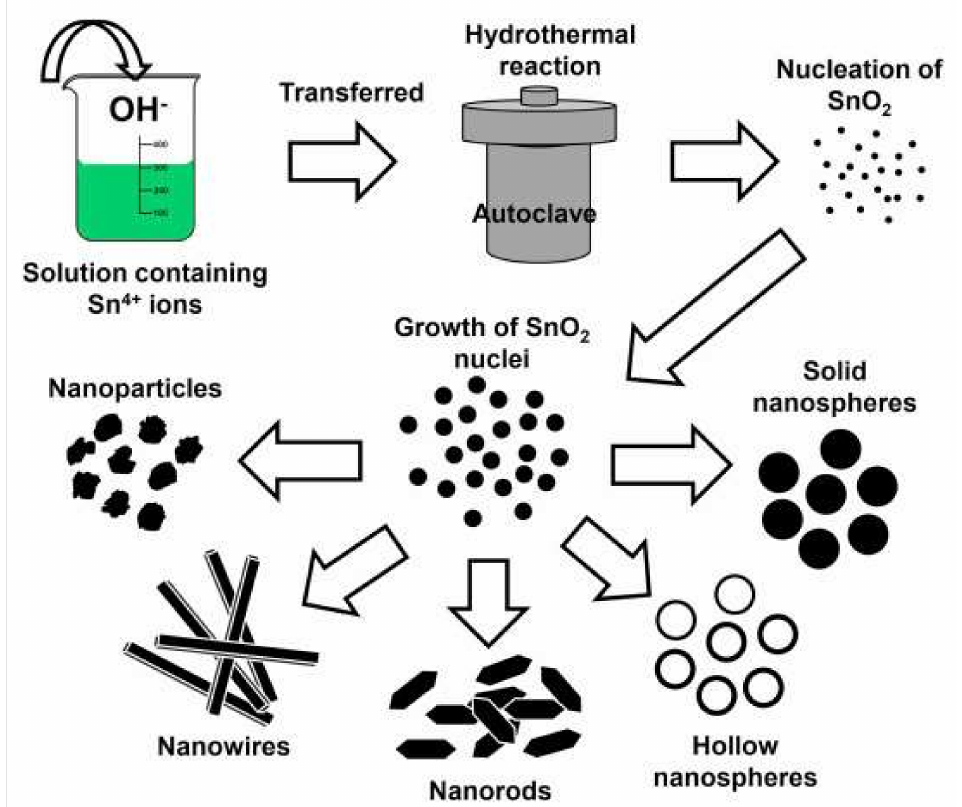
Figure 9. Synthesis routes of various SnO 2 nanostructures using hydrothermal treatment. Repro- duced with permission from Ref. [85]. Copyright 2022 Elsevier.